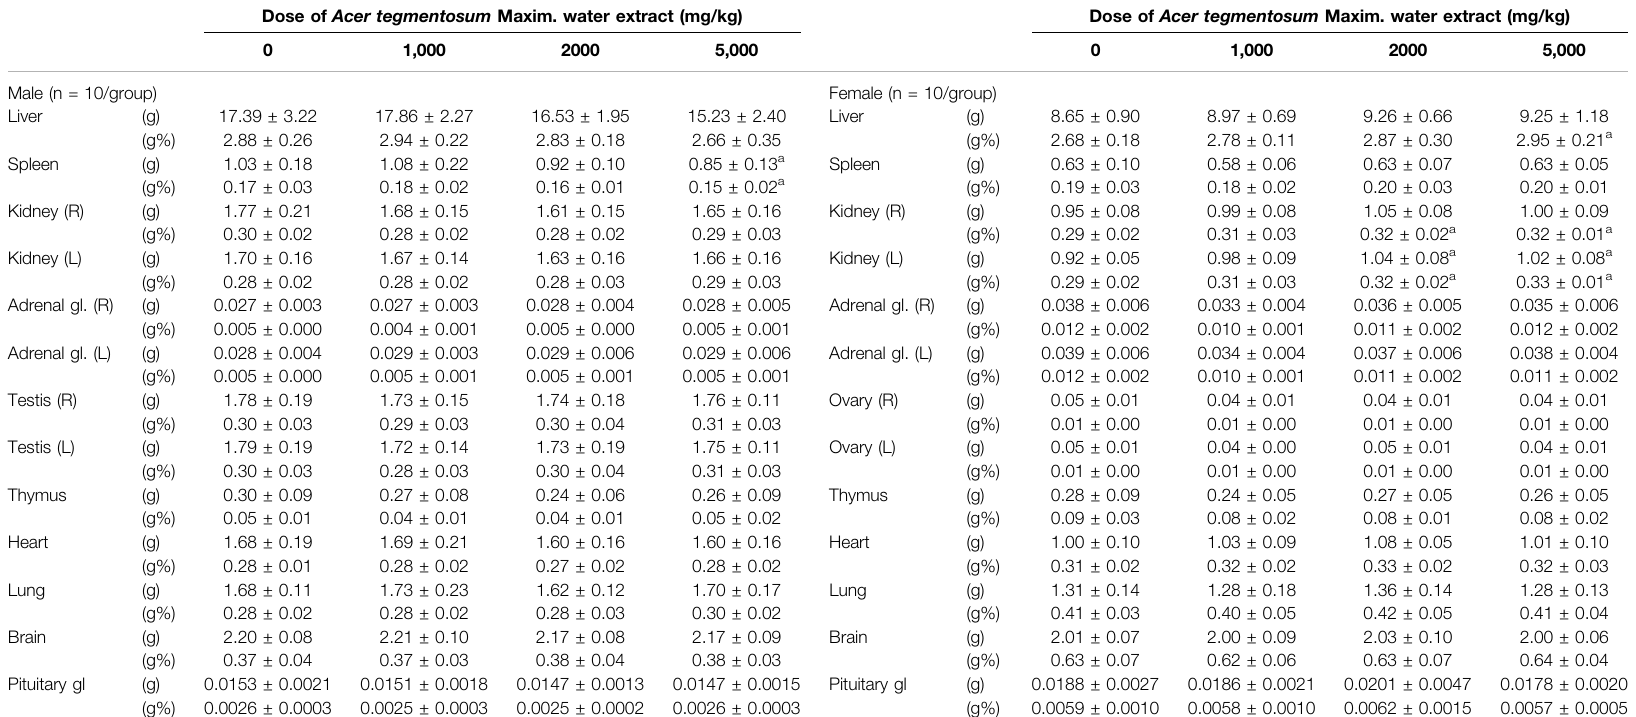
TABLE 4 | Absolute and relative weights of major organs from SD rats orally treated with Acer tegmentosum Maxim. water extract for 13